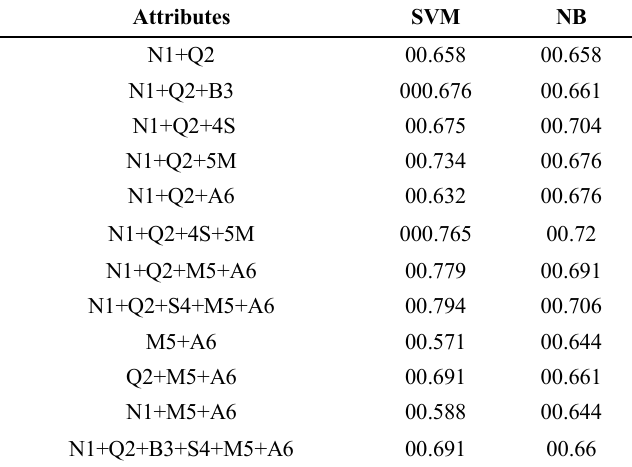
Table 9 . Measure score with classifiers